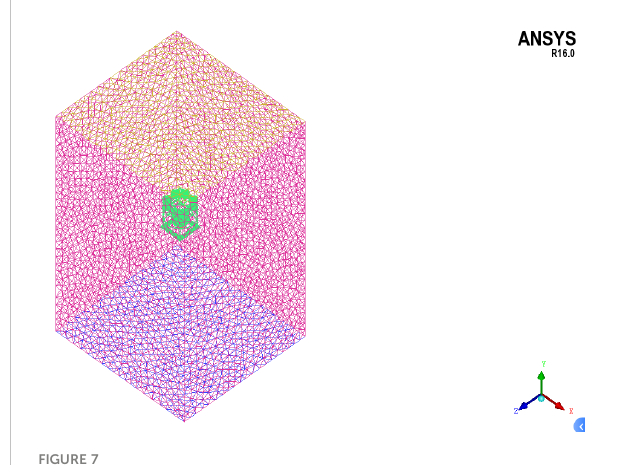
FIGURE 7 Simulation grid division.